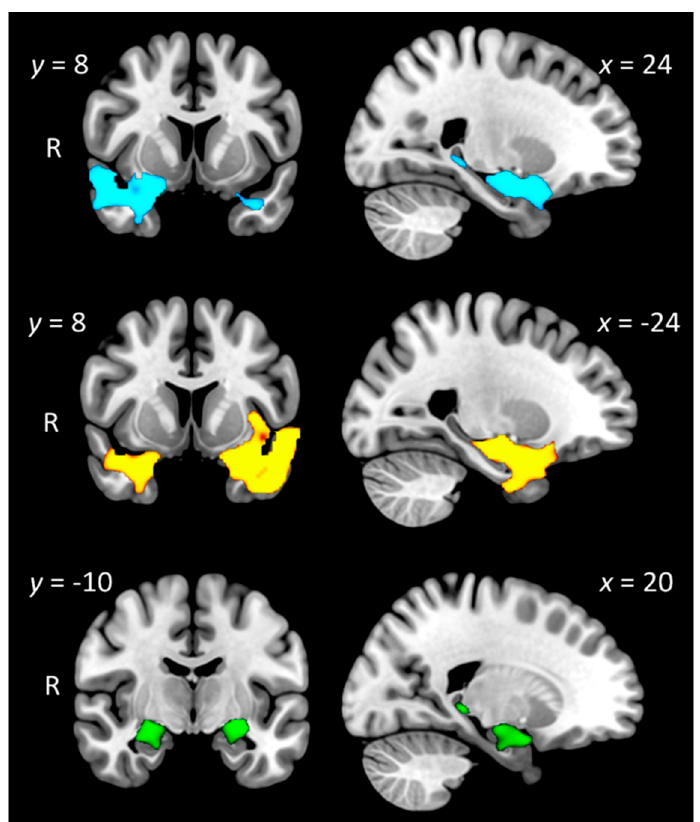
Figure 3. Regions of significant grey matter intensity decrease in right-predominant semantic dementia (SD-R: top panel; blue); left-predominant semantic dementia (SD-L: middle panel; yellow) and Alzheimer’s disease (AD: bottom panel; green) relative to Controls. Coloured voxels indicate regions that emerged as significant in the voxel-based morphometry analyses extracted voxelwise and corrected for family-wise error at p < 0.05. ACE-III Total, years in education, and scanning site included as nuisance variables in the analyses. Clusters are overlaid on the Montreal Neurological Institute (MNI) standard brain with x and y coordinates reported in MNI standard space. R = right. Figures created using MRIcroGL. Table 3. Voxel-based morphometry results showing regions of significant grey matter intensity decrease in Alzheimer’s disease, left-predominant semantic dementia, and right-predominant semantic dementia, relative to Controls. Contrast Regions Side Cluster Size t Value Peak MNI Coordinates x y z Temporal pole, orbitofrontal cortex, Controls— anterior temporal fusiform cortex, anterior SD-R superior/middle temporal gyrus, insular cortex, amygdala, putamen, pallidum, hippocampus, parahippocampal gyrus Hippocampus, amygdala Hippocampus, thalamus Anterior and posterior temporal fusiform cortex, anterior and posterior parahippocampal gyrus, hippocampus, Controls— amygdala, temporal occipital fusiform SD-L cortex, temporal pole, orbitofrontal cortex, insular cortex, putamen, superior/middle temporal gyrus